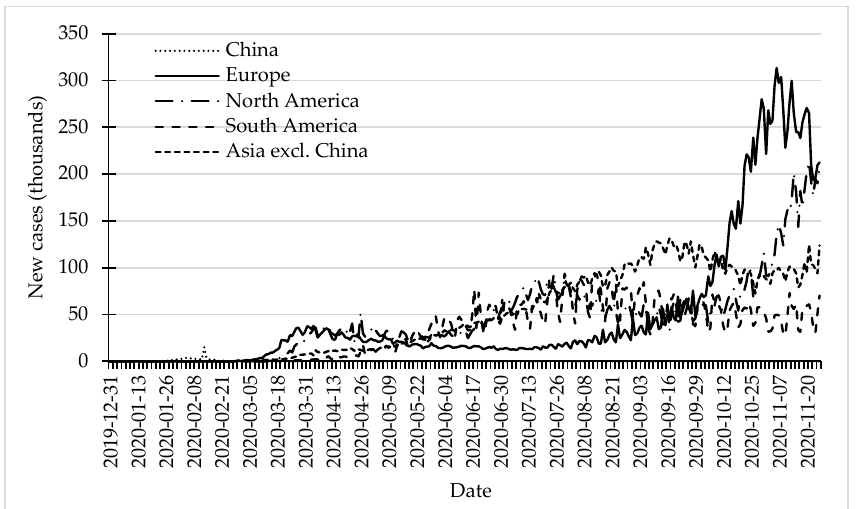
Figure 2. New cases of COVID-19 in selected regions in the period 31 December 2019–26 November 2020. Source: own elaboration on the basis of data from https://ourworldindata.org/coronavirus-source-data (accessed on 15 February 2021).